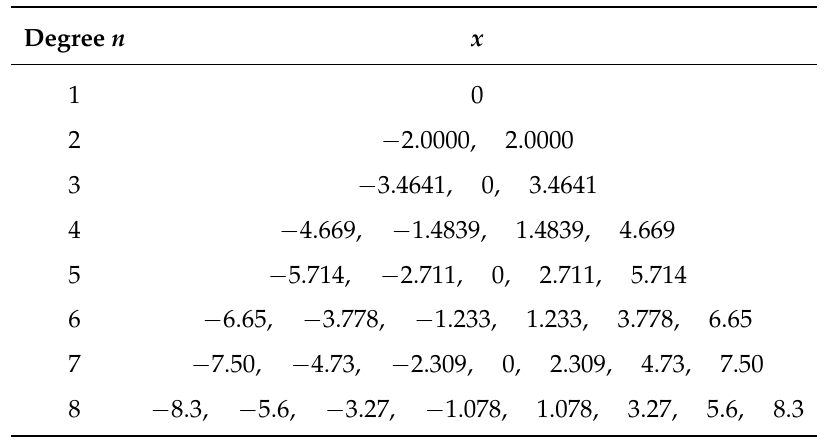
Table 3. Approximate solutions of H n ( x , − 2 ) = 0, x ∈ R